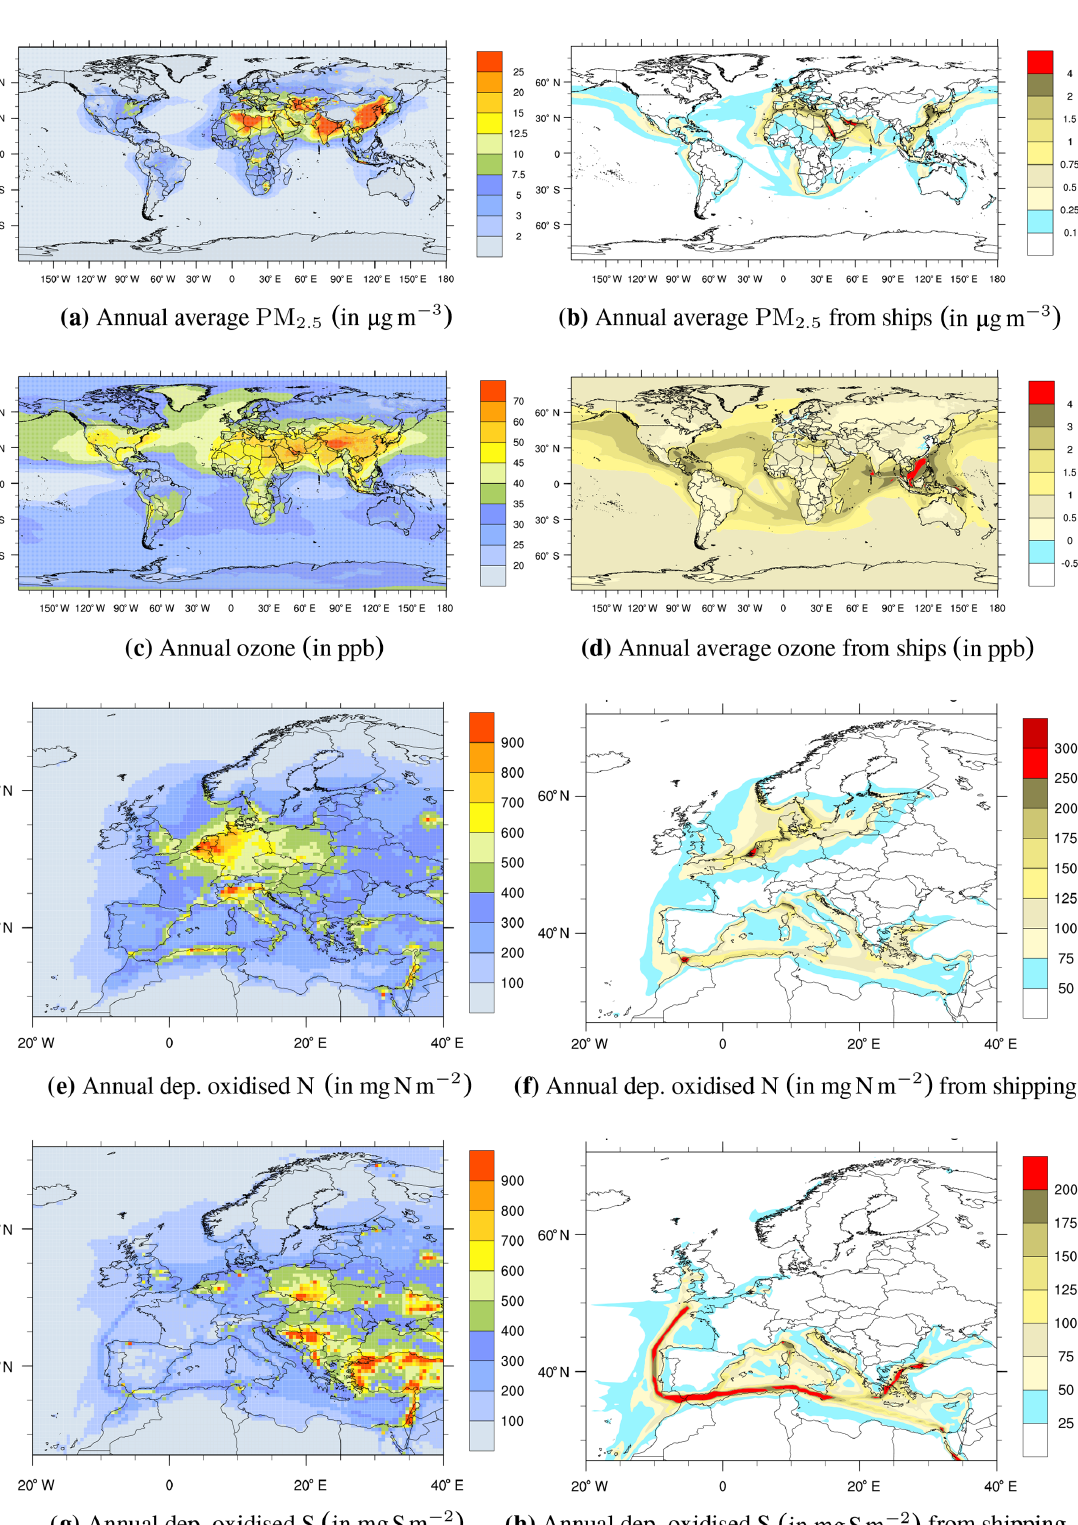
Figure 2. On the right, annually averaged global concentrations of PM 2 . 5 (a) and O 3 (c) . Depositions of oxidised nitrogen (e) and sulfur (g) . On the left, contributions from global shipping to PM 2 . 5 (b) and O 3 (d) and to depositions of oxidised nitrogen (f) and sulfur (h) . The contributions from shipping have been multiplied by 100 /